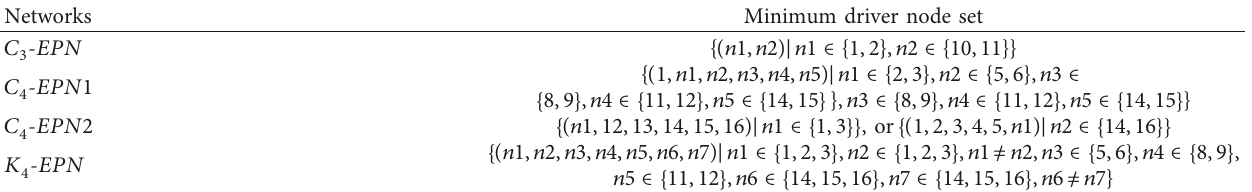
- EPN , C - EPN , and K 3 4